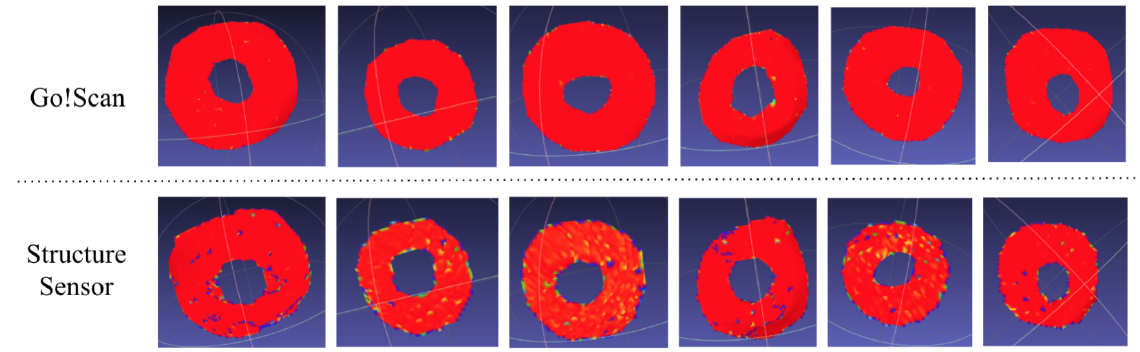
Figure 22. Examples of gaussian curvature calculation for surfaces acquired using the Go!Scan 20 and Structure